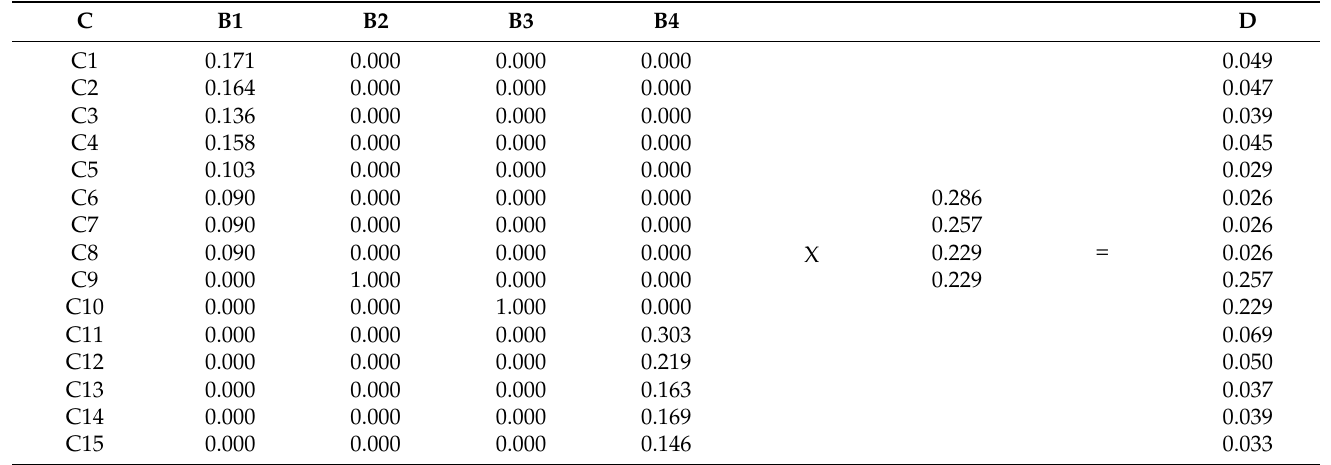
Table 11. Matrix of priorities (C).